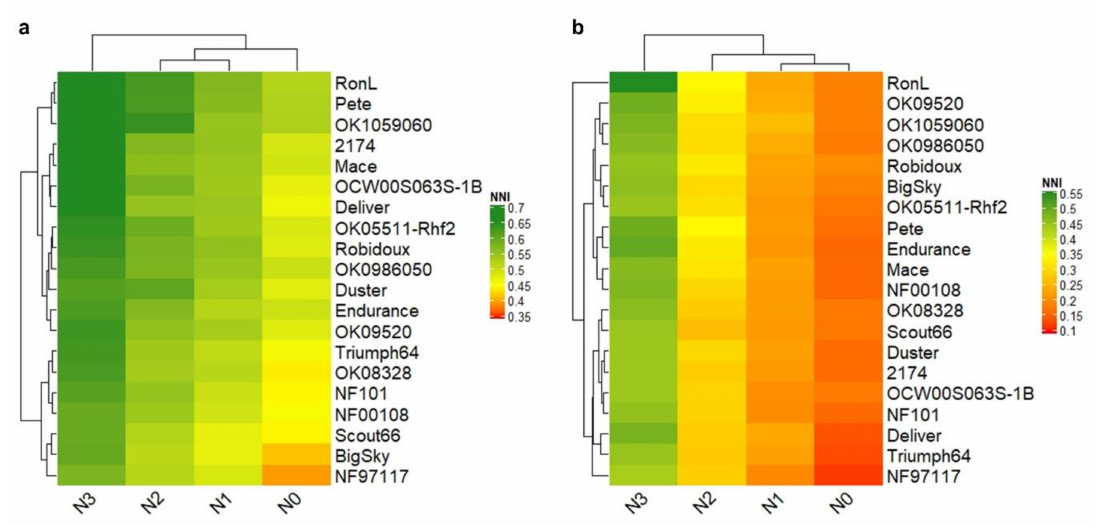
Figure 4. Heatmap among four di ff erent nitrogen treatments for the nitrogen nutrition index (NNI) of 20 wheat lines evaluated in greenhouse ( a ) and hoop house ( b